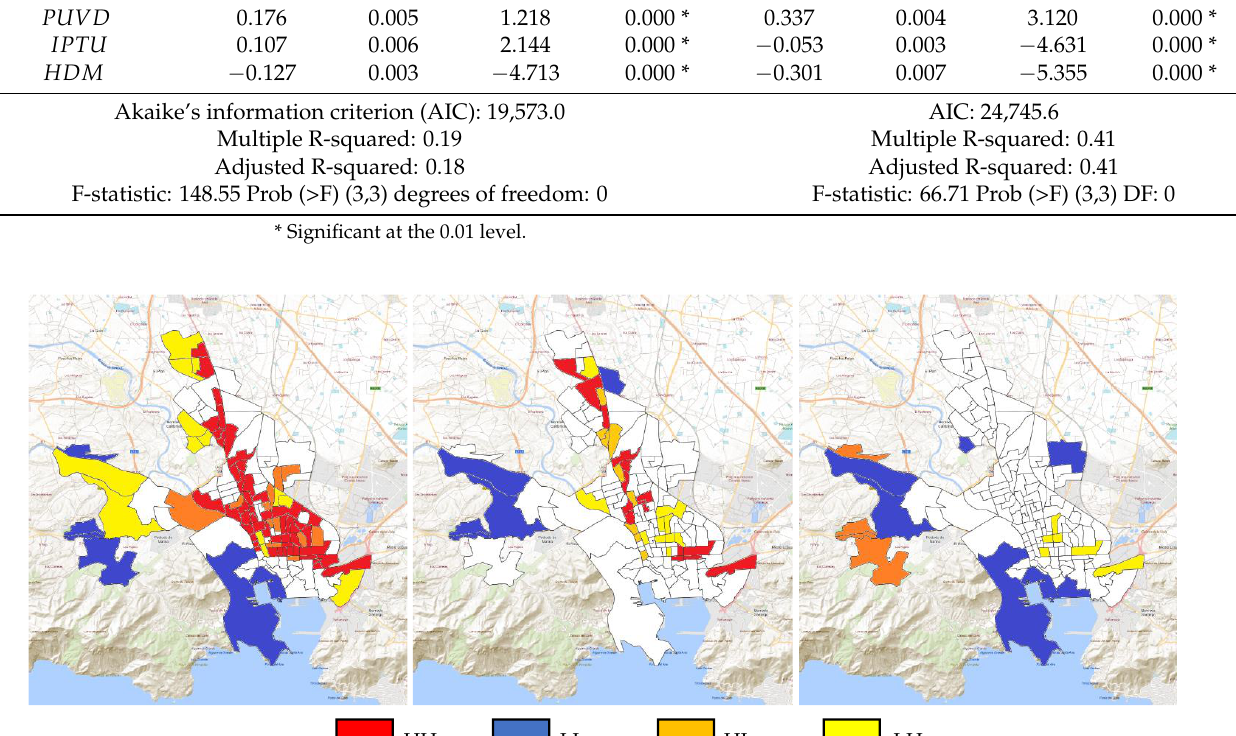
HH LL HL LH Figure 2. Current trend of LISA hot spots maps between mobility indicators and AQI for March and April 2021 (case order: PVUD-EAQI/IPTU-EAQI/HMD-EAQI).